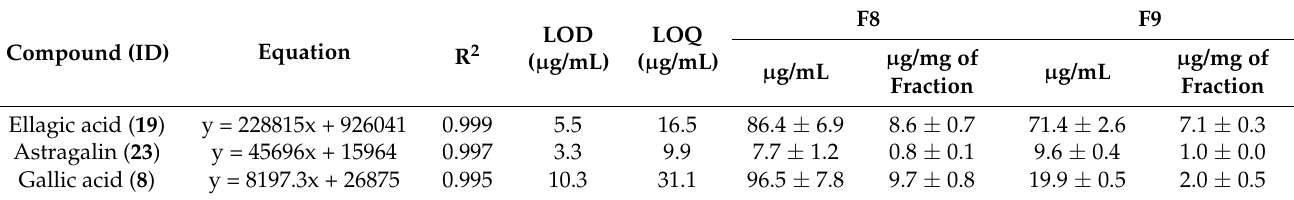
Table 3. Concentration of the major compounds in the two most active fractions.